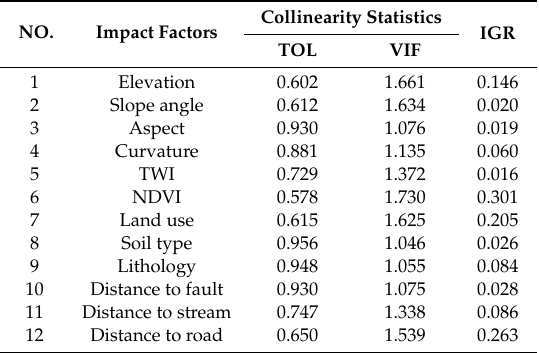
Table 2. Multi-collinearity and IGR among impact